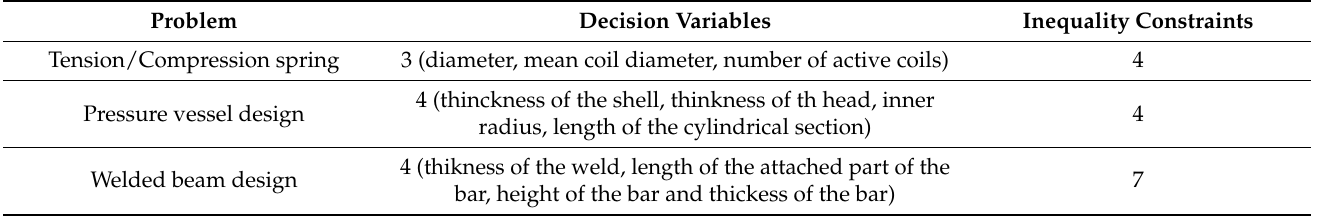
Table 7. Real-world problems